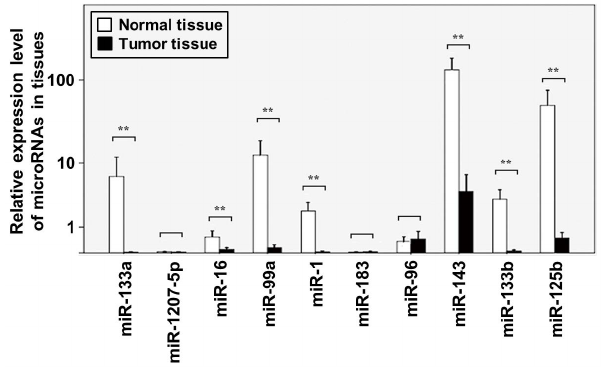
Figure 2. Validation study of the down-regulated expression of 10 selected microRNAs in bladder cancer tissues by RT-qPCR. The total RNA was extracted from 18 pairs of bladder cancer tissues and their corresponding normal adjacent mucosa tissues. The levels of these microRNAs were quantified by RT-qPCR in duplicate. The relative expression levels (2- D Cq) are presented. A paired Mann-Whitney U test was conducted to compare the tumors and their corresponding normal mucosa tissues in UCB patients. Columns, Means; Bars, S.D.; n=18. ** denotes p , 0.001.